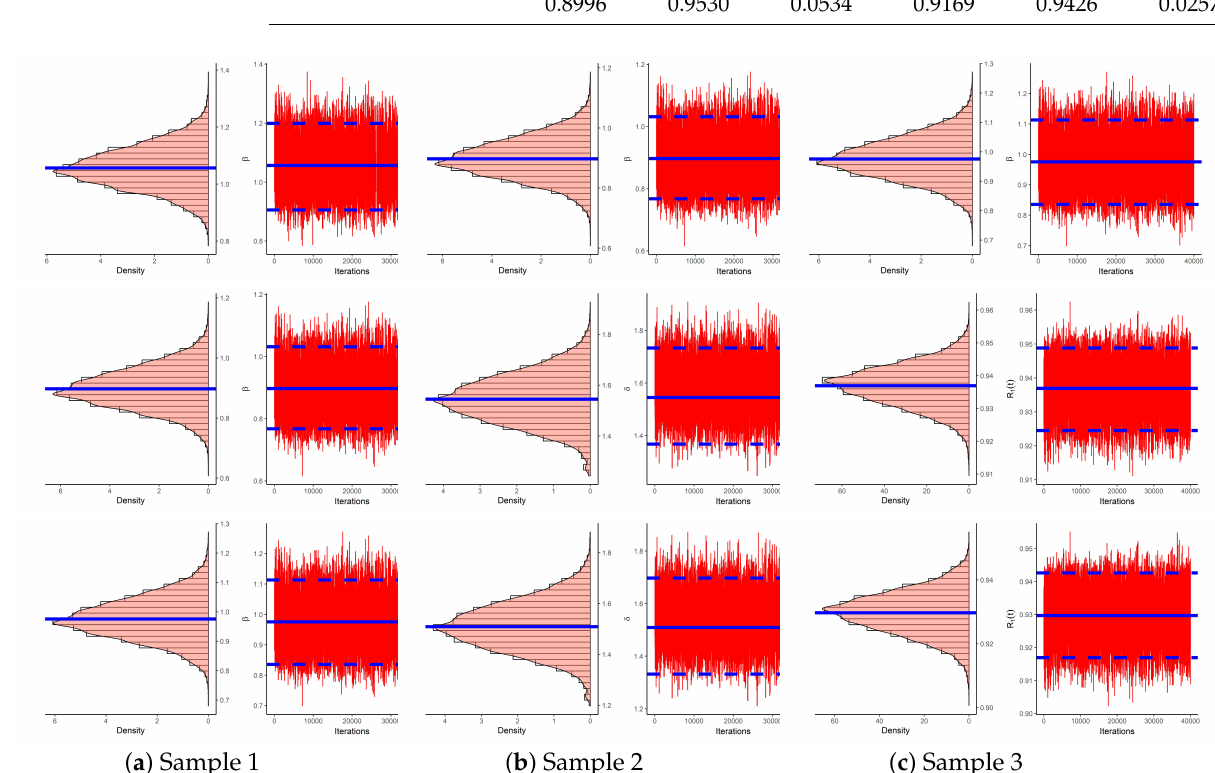
Figure 11. Density ( left ) and Trace ( right ) plot of β , δ and R 1 ( t ) from LED